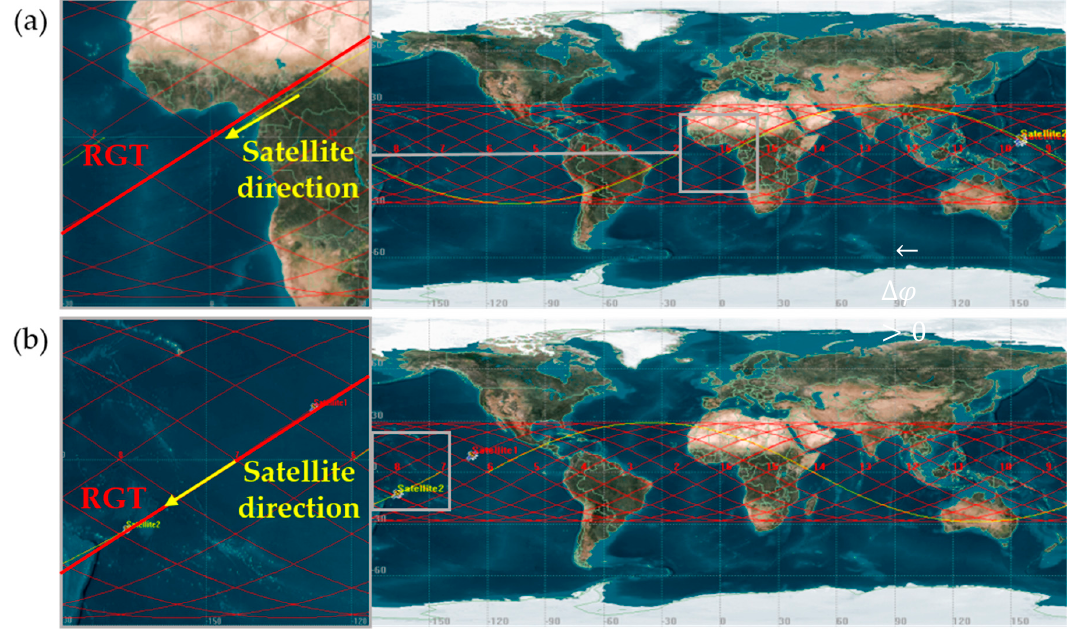
Figure 6. Reconfiguration time: ( a ) Target identification at t = T 0 (satellite not aligned with repeat groundtracks); ( b ) Orbit transfer from GOM to ROM at t = T 0 + T R (satellite aligned with repeat groundtracks).